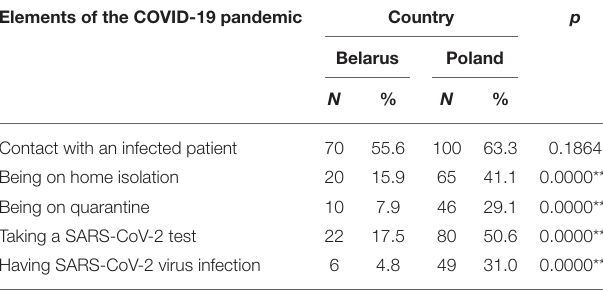
TABLE 1 | Elements of the COVID-19 pandemic among nurses in Poland and Belarus. Elements of the COVID-19 pandemic